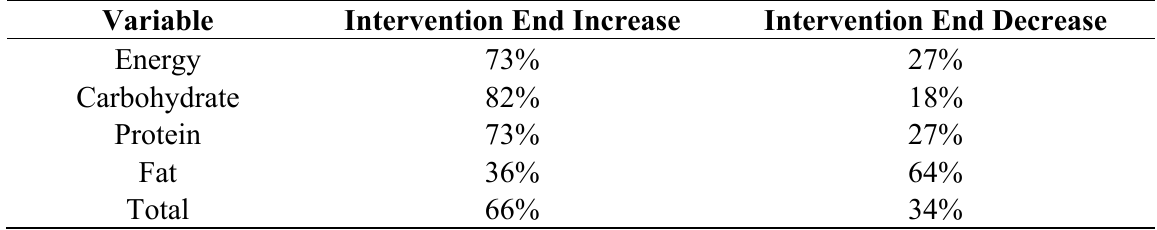
Table 3. Percentage of participants either increasing or decreasing dietary intake according to variable upon completion of the study. Variable Intervention End Increase Intervention End Decrease Energy 73% 27% Carbohydrate 82% 18% Protein 73% 27% Fat 36% 64% Total 66% 34% Values are expressed as mean percentages. Total expressed as mean